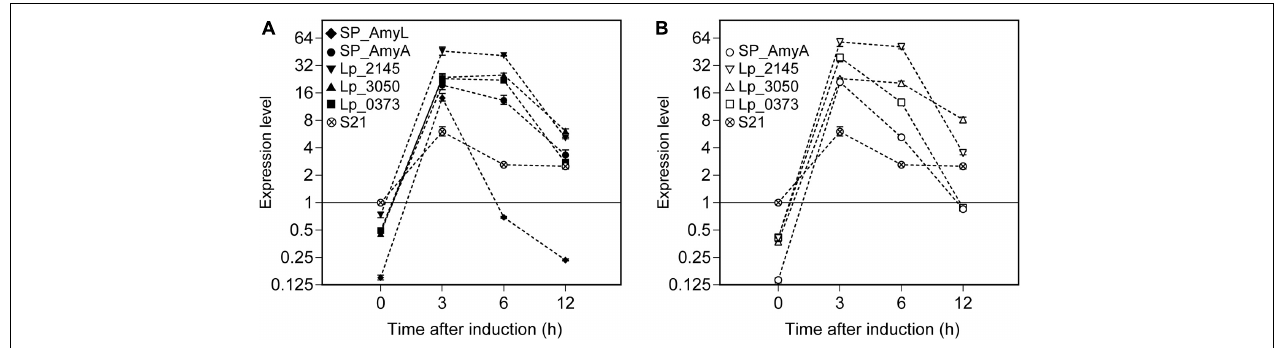
FIGURE 6 | Expression levels of (A) L. plantarum S21 α -amylase ( amyL ) and (B) L. amylovorus NRRL B-4549 truncated α -amylase ( amyA ) in recombinant L. plantarum WCFS1 strains harboring various secretion plasmids calculated using REST 2009. A cDNA sample of L. plantarum S21 at 0 h was used as control, and its expression level was taken as 1. Values given are the average values from at least two independent experiments. The error bars indicate 95% confidence intervals (CI) calculated by REST